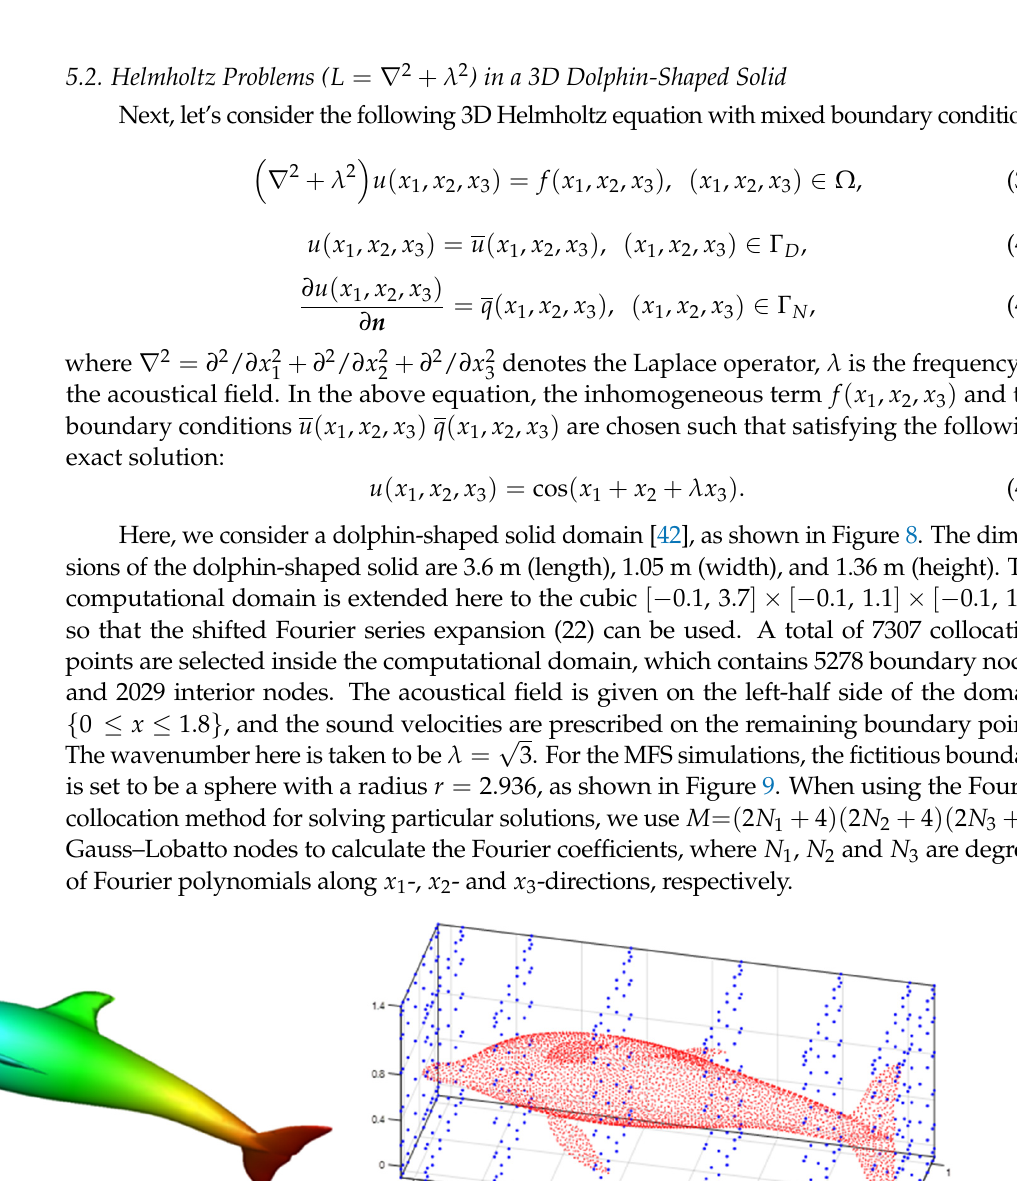
Figure 9. The profile of the dolphin-shaped solid, where “O” and “•” denote the source points (MFS) and boundary points, respectively. Table 3 lists the maximum and global errors of the sound results calculated using the proposed FCM-MFS approach, as the degrees of Fourier polynomials increase from 1